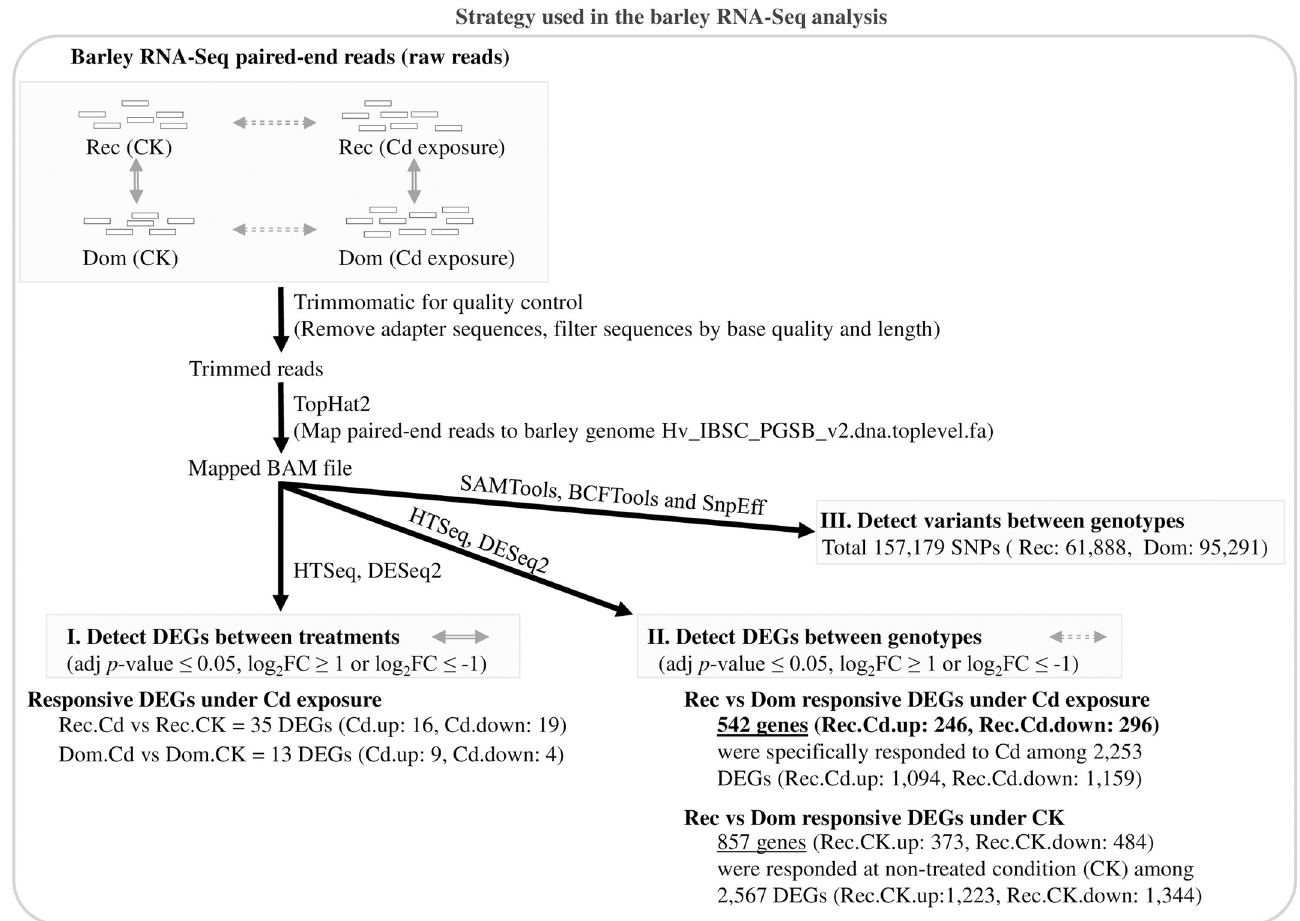
Fig 3. General workflow used in the barley RNA-Seq analysis. After quality control of raw reads by FastQC, we used Trimmomatic to trim low-quality bases. The Bowtie v2.3.4.1 software was used to make a barley genome index. The clean reads obtained from the RNA-Seq data were mapped to the barley genome assembly using Tophat v2.1.1 and the alignments were sorted by SAMTools v1.8. HTSeq-counts v0.9.1 was used to generate read counts of each gene, and DESeq2 v3.7 was used to identify DEGs between treatments and genotypes. Detection of variants was performed using SAMTools v1.8, BCFTools and snpEff